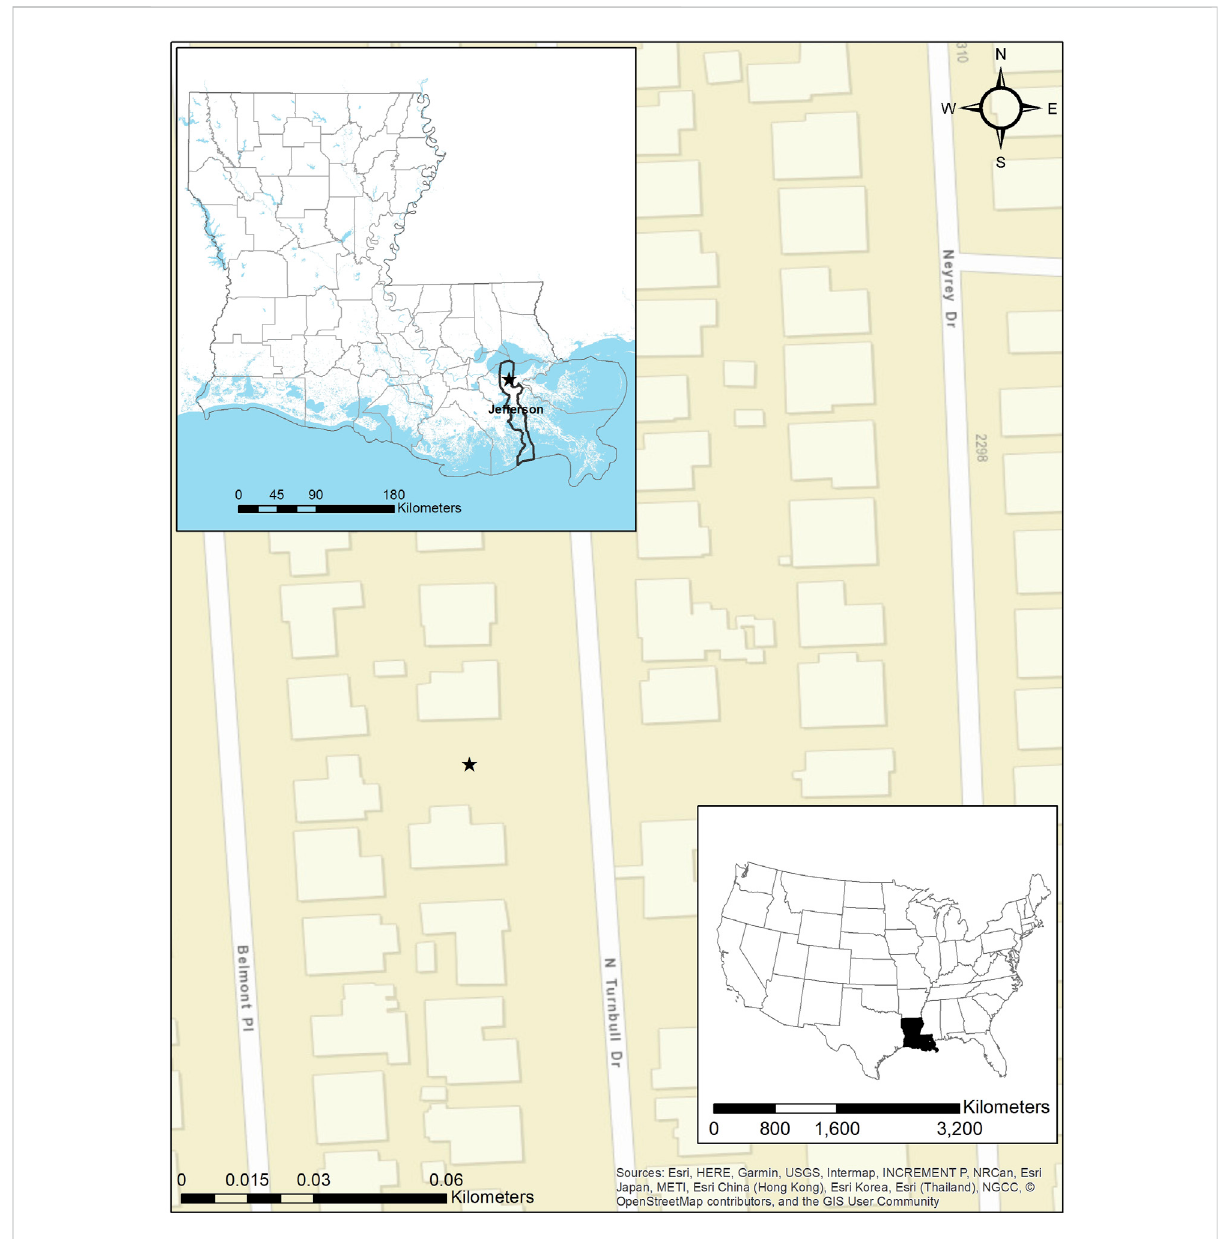
FIGURE 2 Metairie, Jefferson Parish, Louisiana, with star representing proposed building